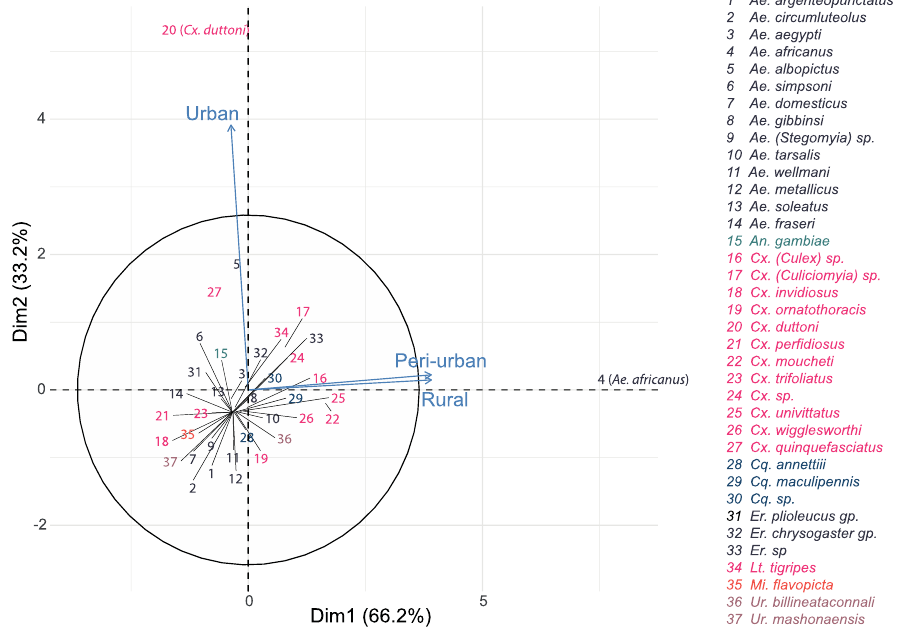
Figure 4. Principal component analysis representing the relationship between mosquito species abundance and habitat types.